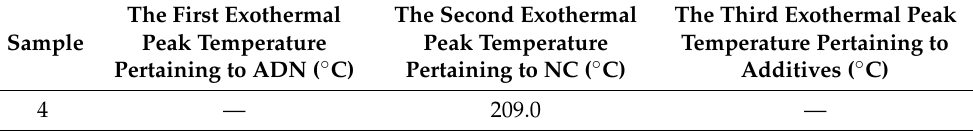
Figure 5. DSC curves of several single energetic materials and NC − based composite fibers. ( a ): DSC curves of explosives such as NC, ADN, NC+ADN mixture, RDX and CL-20 , ( b ) DSC curves of sample 1-4. Table 2. Characteristic data for the thermal decomposition of NC-based samples.